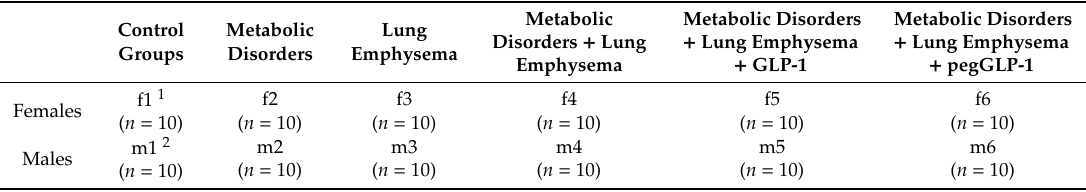
Table 1. Experimental groups in vivo .